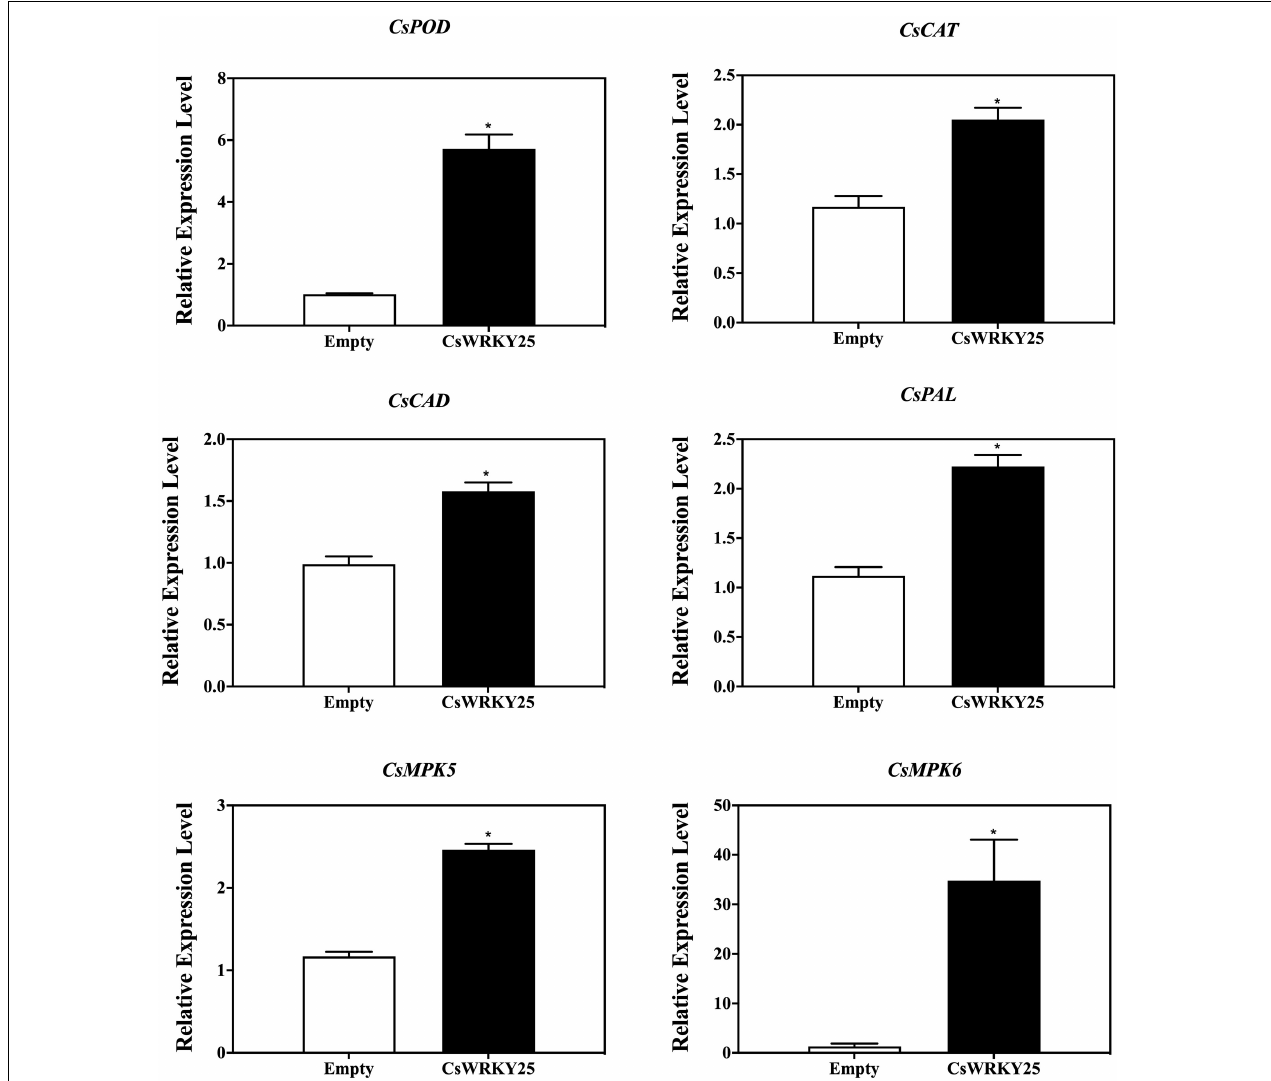
FIGURE 6 | Transcript levels of CsPOD, CsCAT, CsCAD, CsPAL, CsMPK5, and CsMPK6 in pEAQ and CsWRKY25 overexpressed citrus fruit peel. P values were regarded as statistically significant at * P <